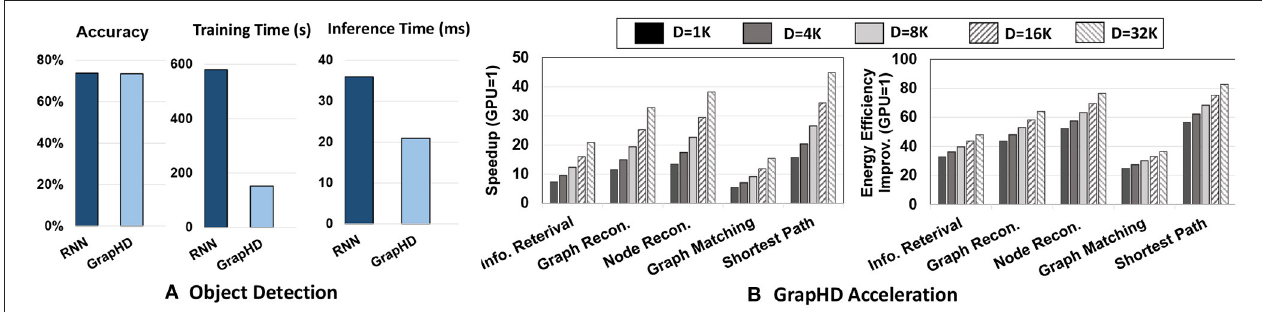
FIGURE 13 | (A) GrapHD vs. RNN for object detection: Accuracy and efficiency. (B) DPIM speedup and energy efficiency running different GrapHD operations over GPU.